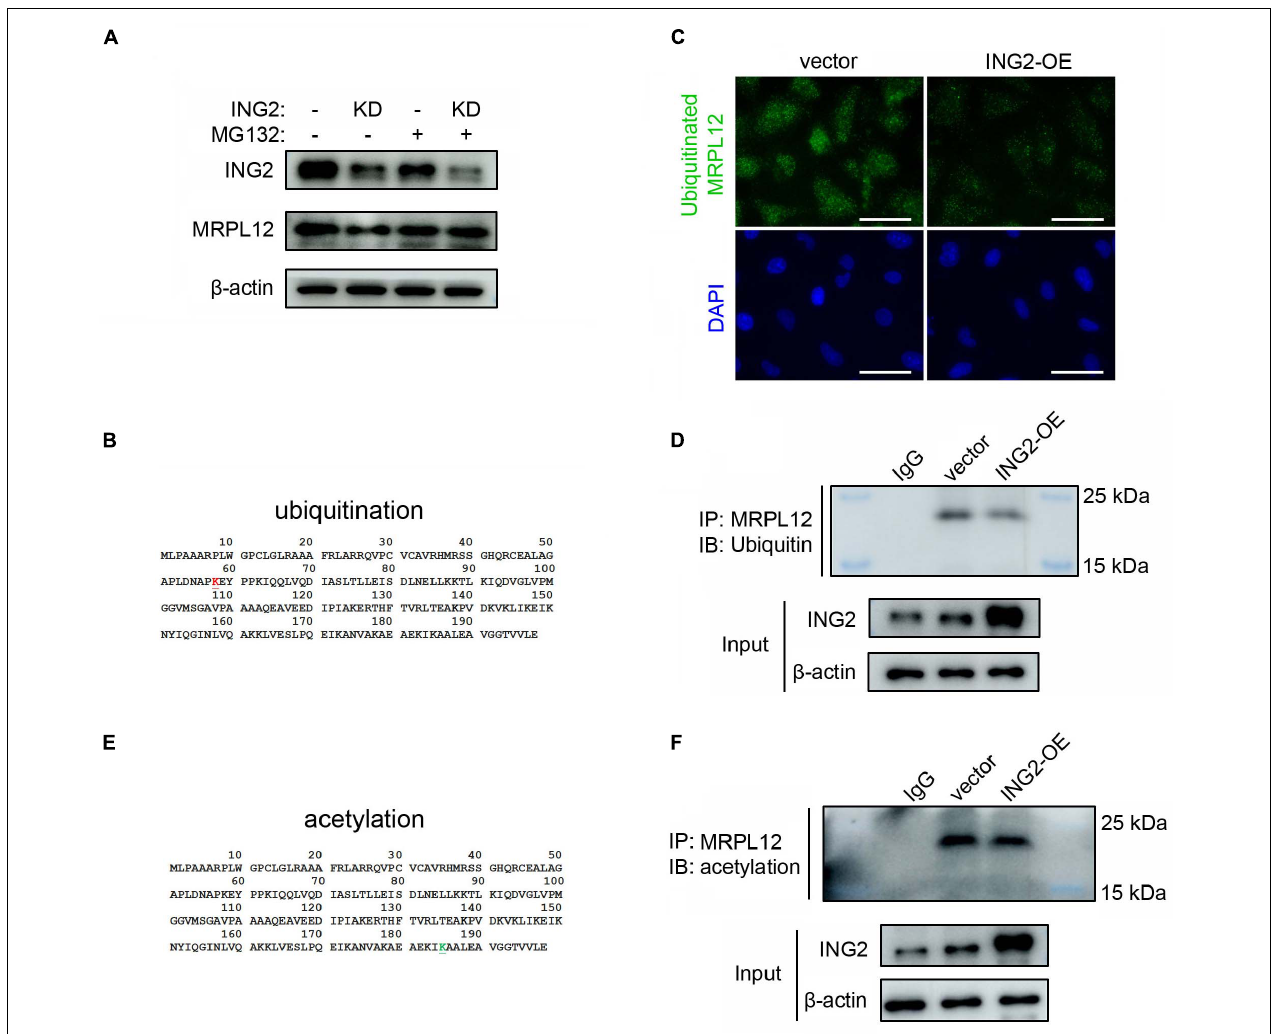
FIGURE 3 | ING2 inhibited the ubiquitination of MRPL12. (A) HK2 cells were transfected with control or ING2-shRNA, followed by MG132 treatment for 6 h. Protein levels of ING2 and MRPL12 were evaluated by Western blotting. (B) A ubiquitin modified site was found at 58 lysine residue (red, upper panel), predicted using predictor of protein ubiquitination sites, UbPred. (C,D) The ubiquitination of MRPL12 was determined by proximity ligation assay (PLA) and immunoprecipitation, respectively, after transfected ING2-overexpression plasmid. (E) By using ASEB, a web tool for predicting protein acetylation site, a acetylation site was detected at the 185 lysine residue (green, lower panel). (F) The acetylation of MRPL12 was determined by immunoprecipitation after transfected ING2-overexpression plasmid. IP, immunoprecipitation; WB, Western blotting. Data were from three individual